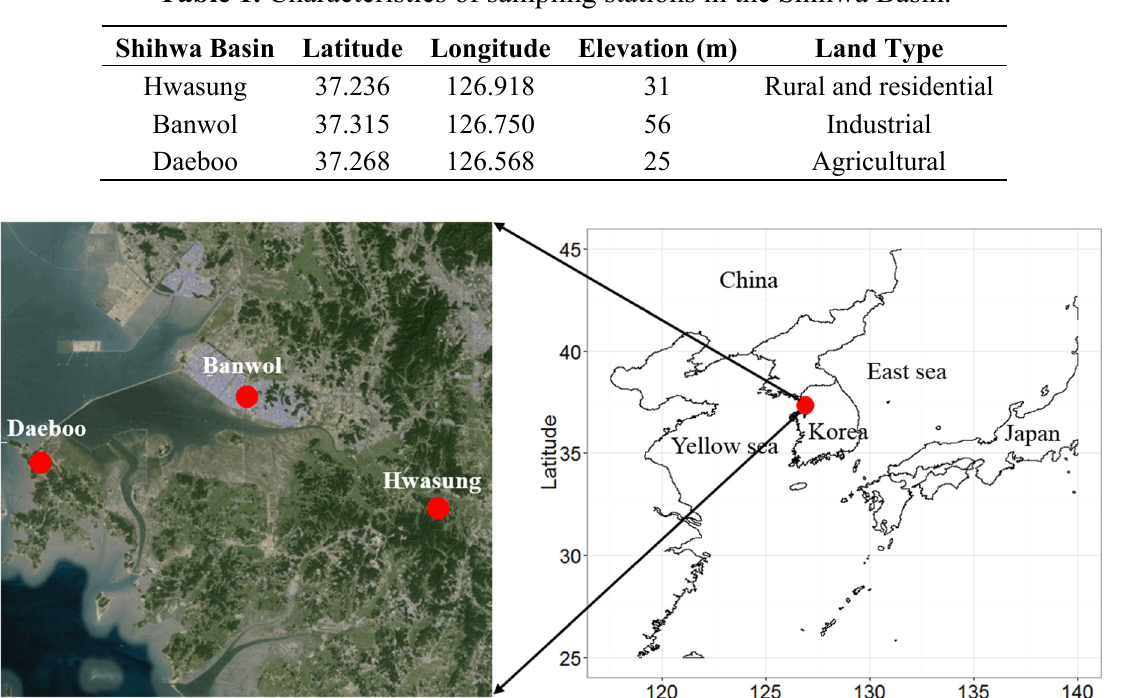
Table 1. Characteristics of sampling stations in the Shihwa Basin.